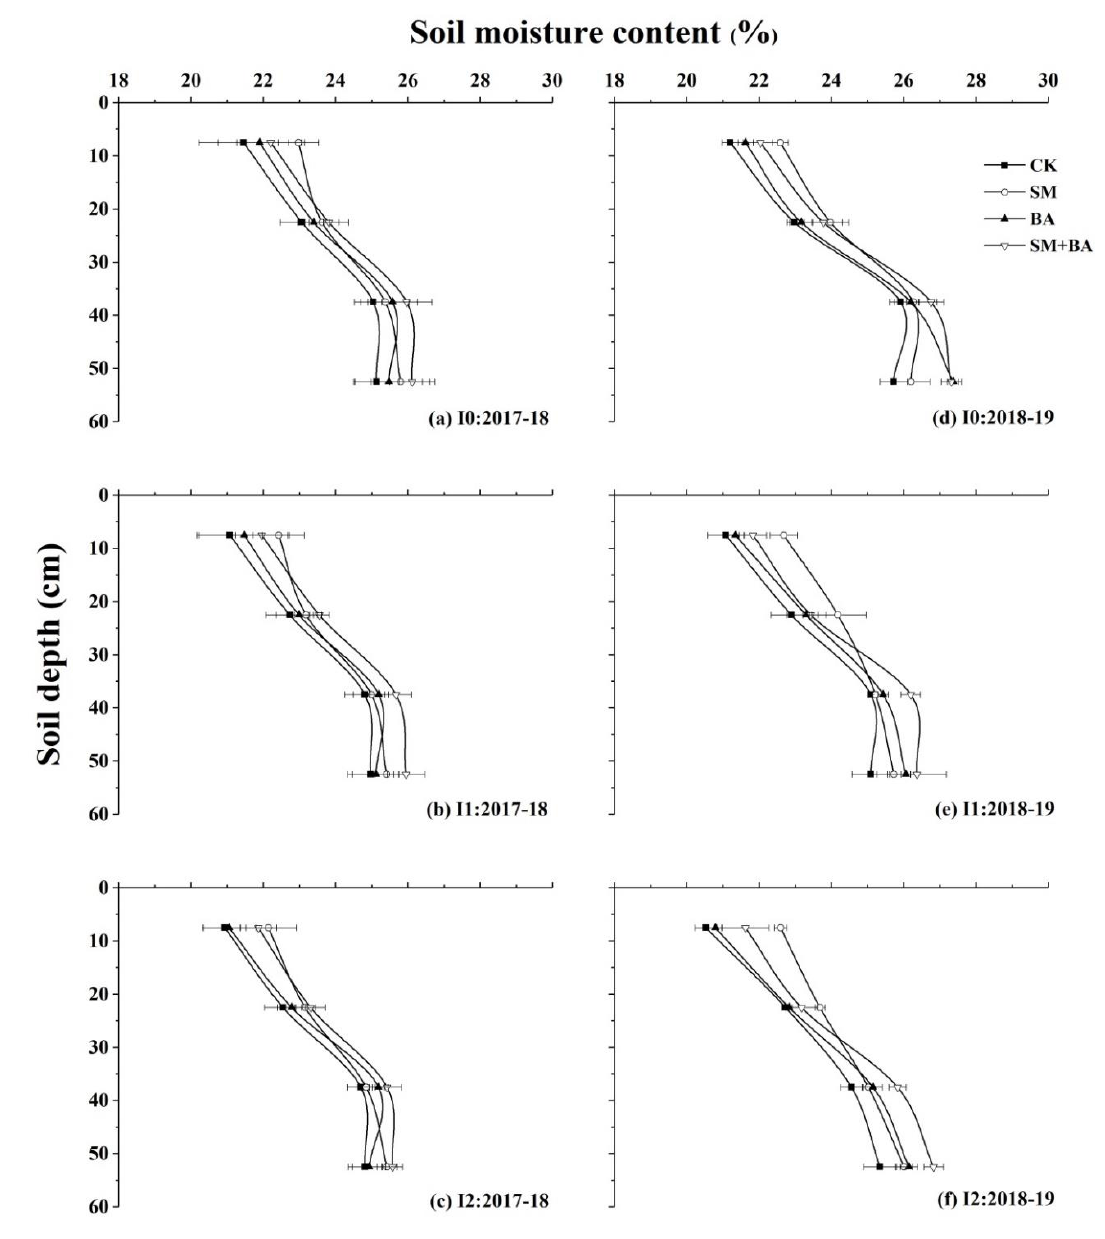
Figure 3. Vertical distribution of soil moisture content within the 0–60 cm soil profiles under different straw-returning modes and irrigation water salinity levels at the time of winter wheat harvest during the 2017–2018 and 2018–2019 growing seasons, respectively. The values are means of three replications ± standard deviation. CK: no straw-returning, SM: straw mulching, BA: biochar amendment, SM+BA: straw mulching with biochar amendment; I0, I1, and I2 indicate an irrigation salinity of 0.47 dS m − 1 , 3.25 dS m − 1 , and 6.75 dS m − 1 ,